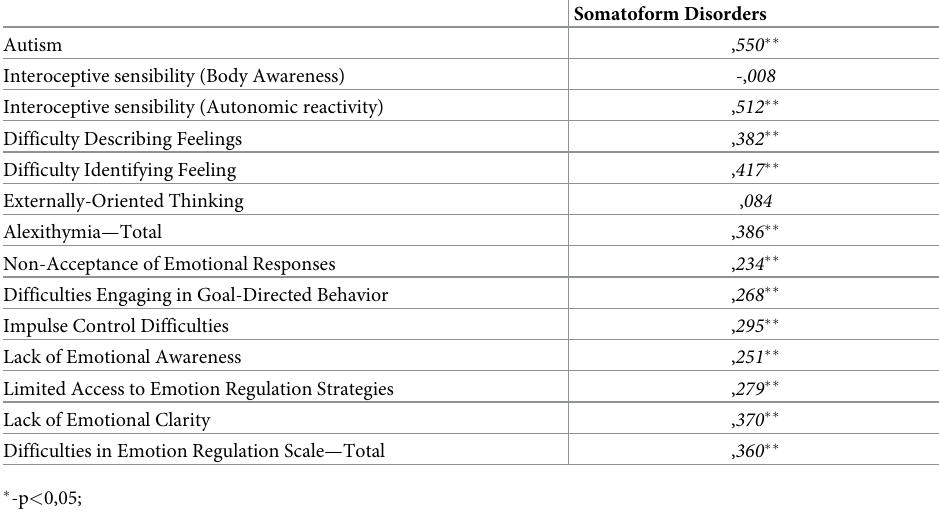
Table 2. The analysis of correlations between particular dimensions of interoceptive sensibility, alexithymia, diffi- culties in emotion regulation, autism and the intensification of somatoform